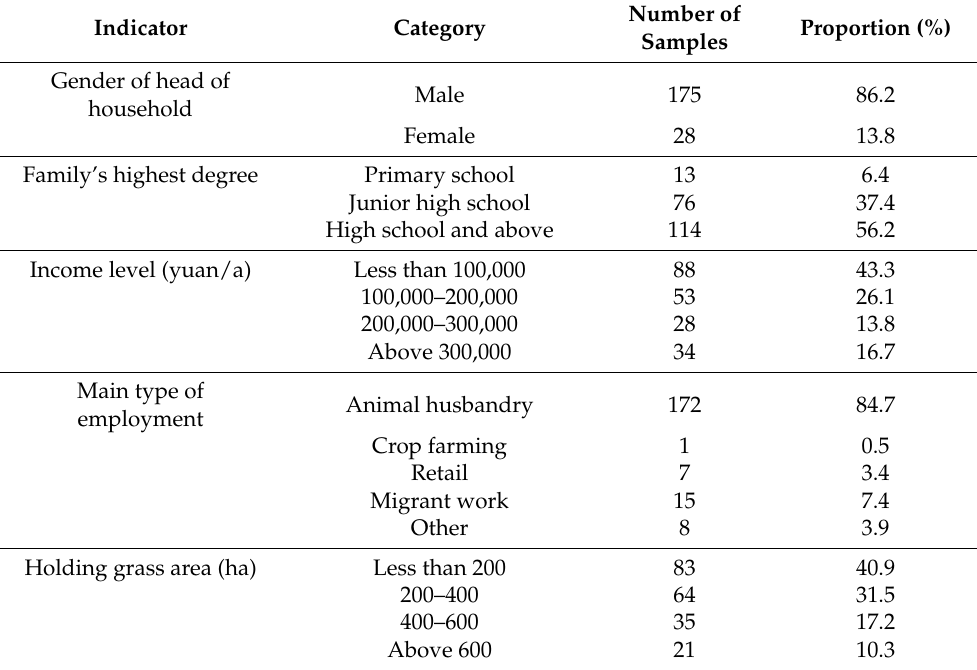
Table 1. Basic characteristics of sample herder